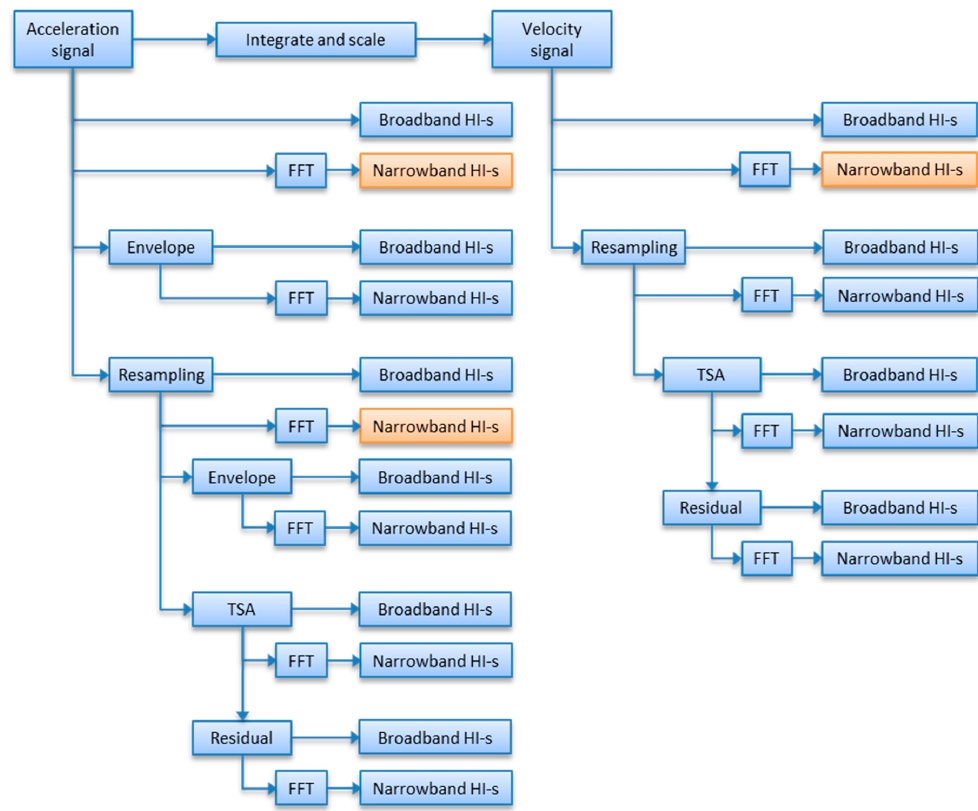
Figure 2. Placement of analyzed scalar machine lar HI-s (health indicators).